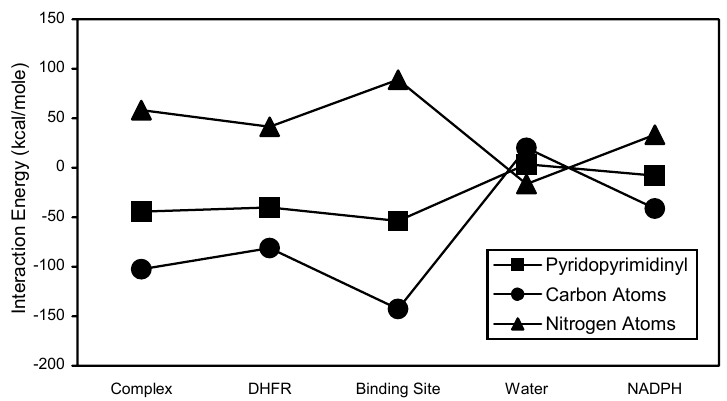
Figure 9. Comparison of interaction energy analysis of the pyridopyrimidinyl region of TMQ with its carbon and nitrogen atoms.